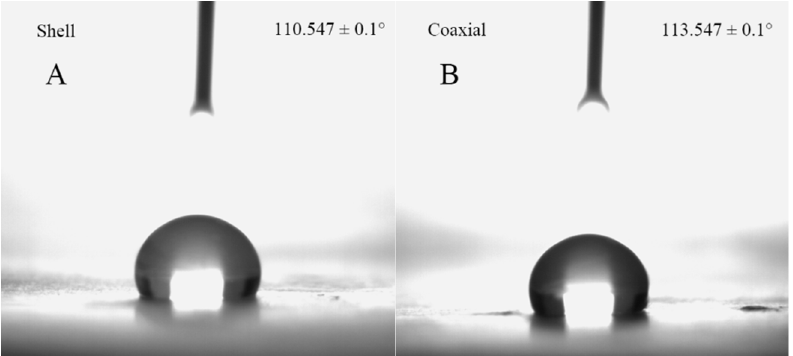
Figure 5. Water contact angles of ( A ) shell and ( B ) coaxial electrospun nanofiber films.